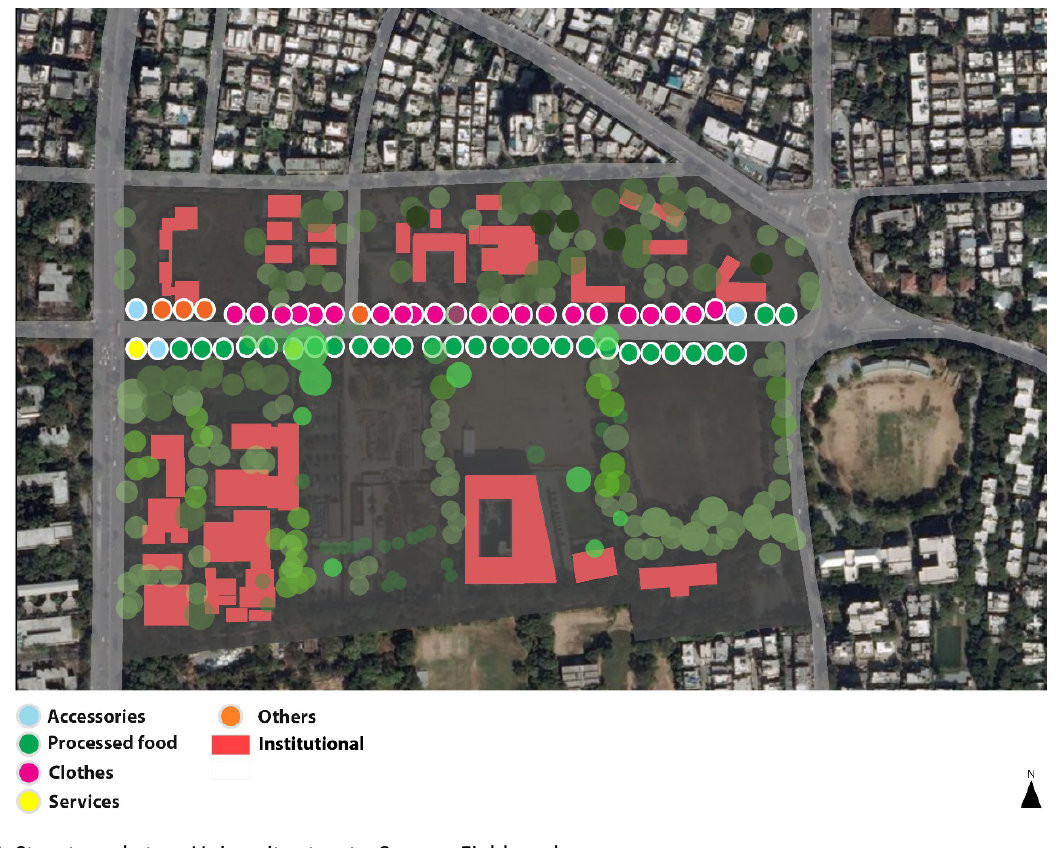
Figure 5. Street market on University streets. Source: Field work.